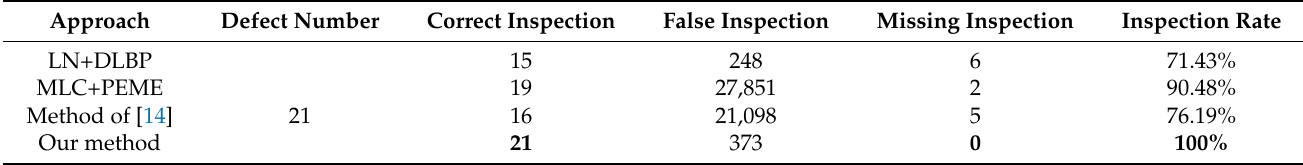
Table 3. Statistics of the inspection results for the actual rail